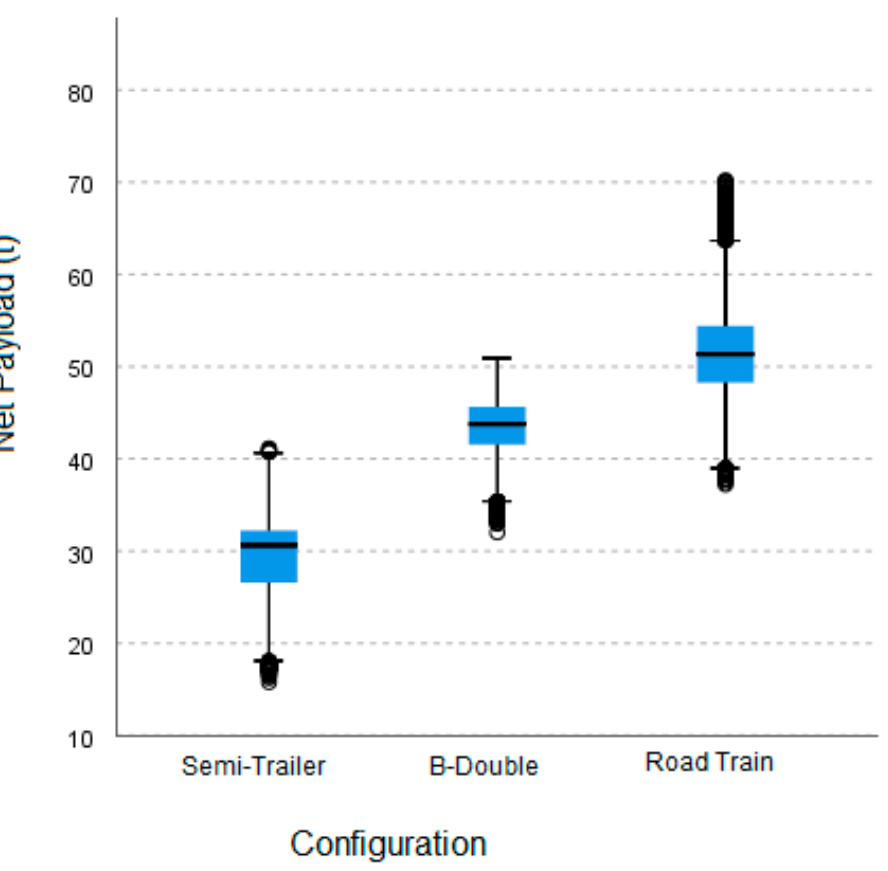
Figure 3. Net payload statistical characteristics box plot of independent samples Kruskal–Wallis Test.